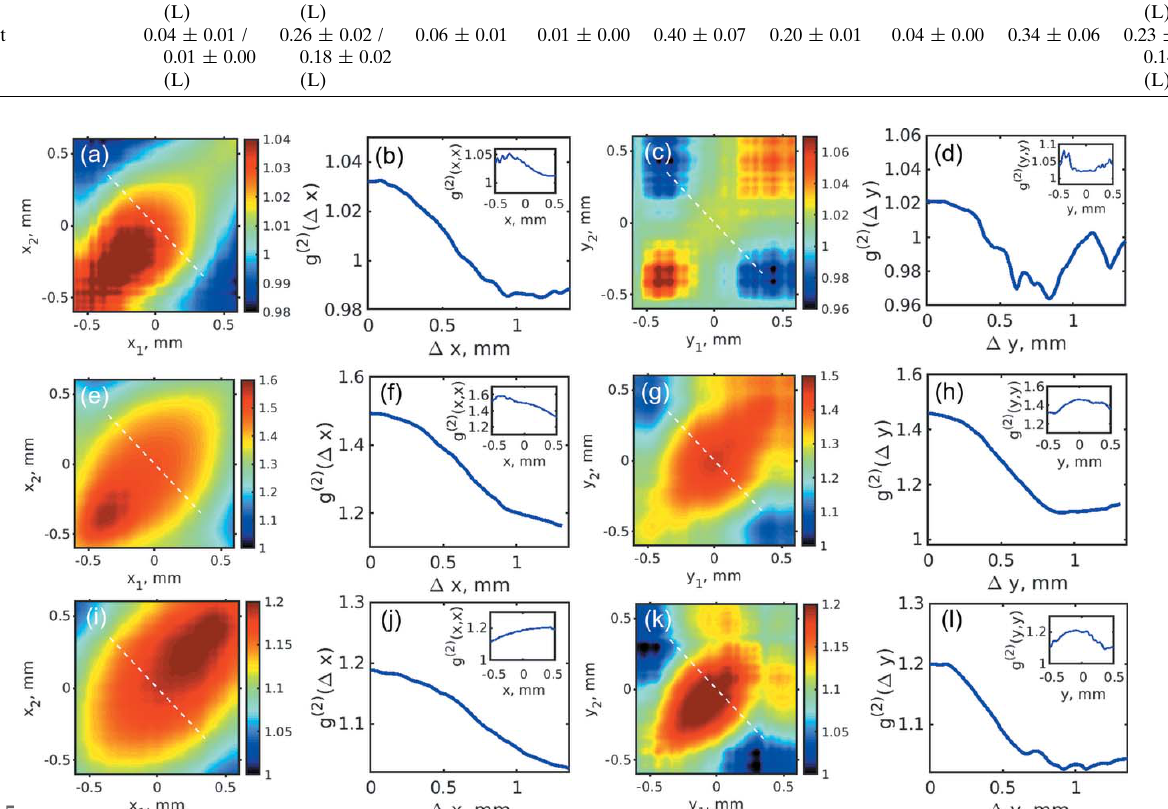
Figure 5 Intensity correlation functions g (2) ( x 1 , x 2 ) ( a , e , i ) and g (2) ( y 1 , y 2 ) ( c , g , k ) measured in the horizontal and vertical directions, respectively. Profiles of the g (2) ( (cid:2) x ) ( b , f , j ) and g (2) ( (cid:2) y ) ( d , h , l ) functions taken along the white dashed lines shown in panels ( a , e , i ) and ( c , g , k ), respectively. In the inset the corresponding autocorrelation functions g (2) ( x , x ) and g (2) ( y , y ) taken along the diagonal lines of g (2) functions are shown. ( a – d ) SASE radiation, ( e – h ) monochromatic radiation, ( i – l ) self-seeding regime of operation. All results presented in this figure correspond to the 180 pC bunch